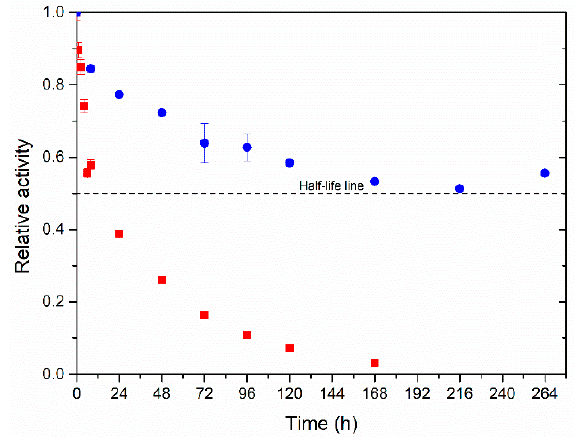
Figure9. Thermal inactivation profilesof NPD,( (cid:4) ) dialyzedfreeand ( • ) immobilizedon agarose-glyoxyl Figure 9. Thermal inactivation profiles of NPD, ( ■ ) dialyzed free and ( ● ) immobilized on agarose- (AgGly), for 24 h at 50 ◦ C and pH 6.5. Activities were measured as described in Section glyoxyl (AgGly), for 24 h at 50 °C and pH 6.5. Activities were measured as described in Section 3.2.